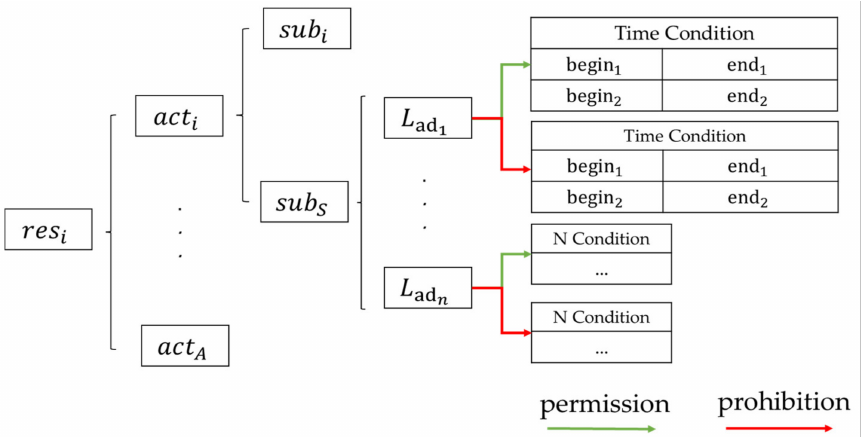
Figure 2. Tree Structure of Policy